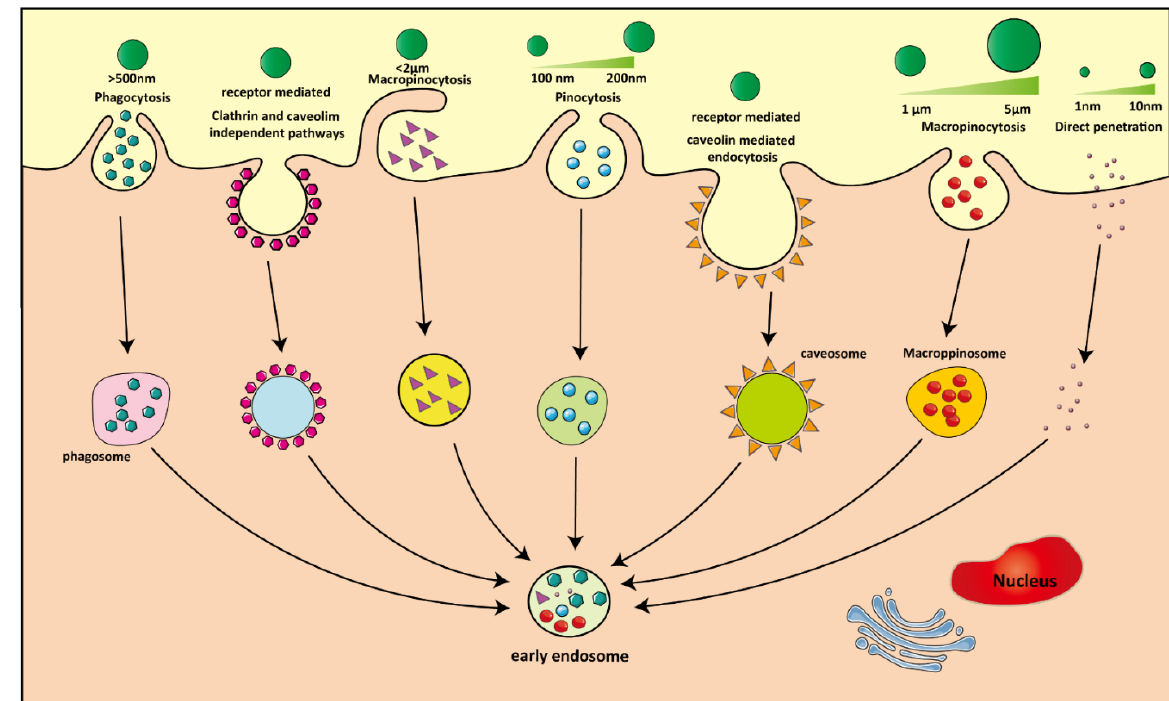
Figure 5. Cellular internalization pathways of nanoparticles (NPs). Depending on their size, NPs enter cells through mechanisms of caveolin- and clathrin-mediated endocytosis, macropinocytosis, phagocytosis or pinocytosis.